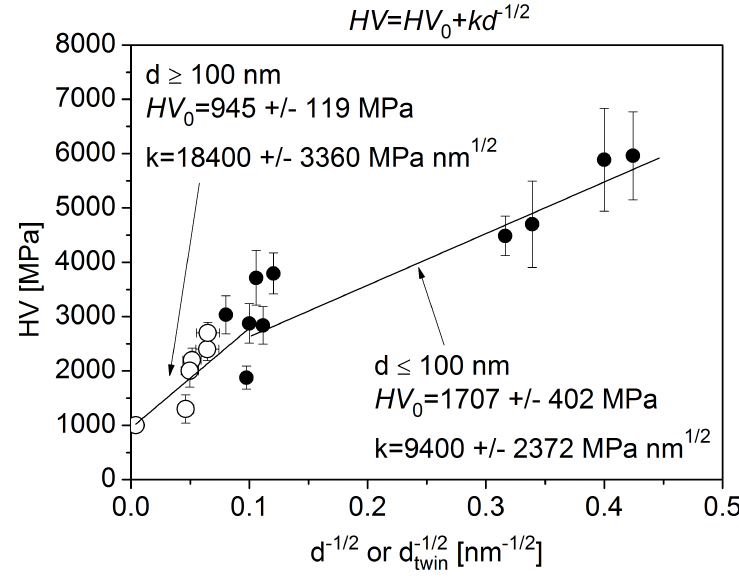
Figure 11. Hall–Petch plot of the hardness versus the inverse square root of the characteristic length in the microstructure (the lowest of the grain size and the twin fault spacing). The solid circles correspond to as-deposited nanocrystalline layers produced with different bath additives (the data were taken from [8]). The open circles show the data obtained on the annealed samples in this study and the new measurements. The straight lines fitted to the data corresponding to the grain sizes smaller and larger than 100 nm are also